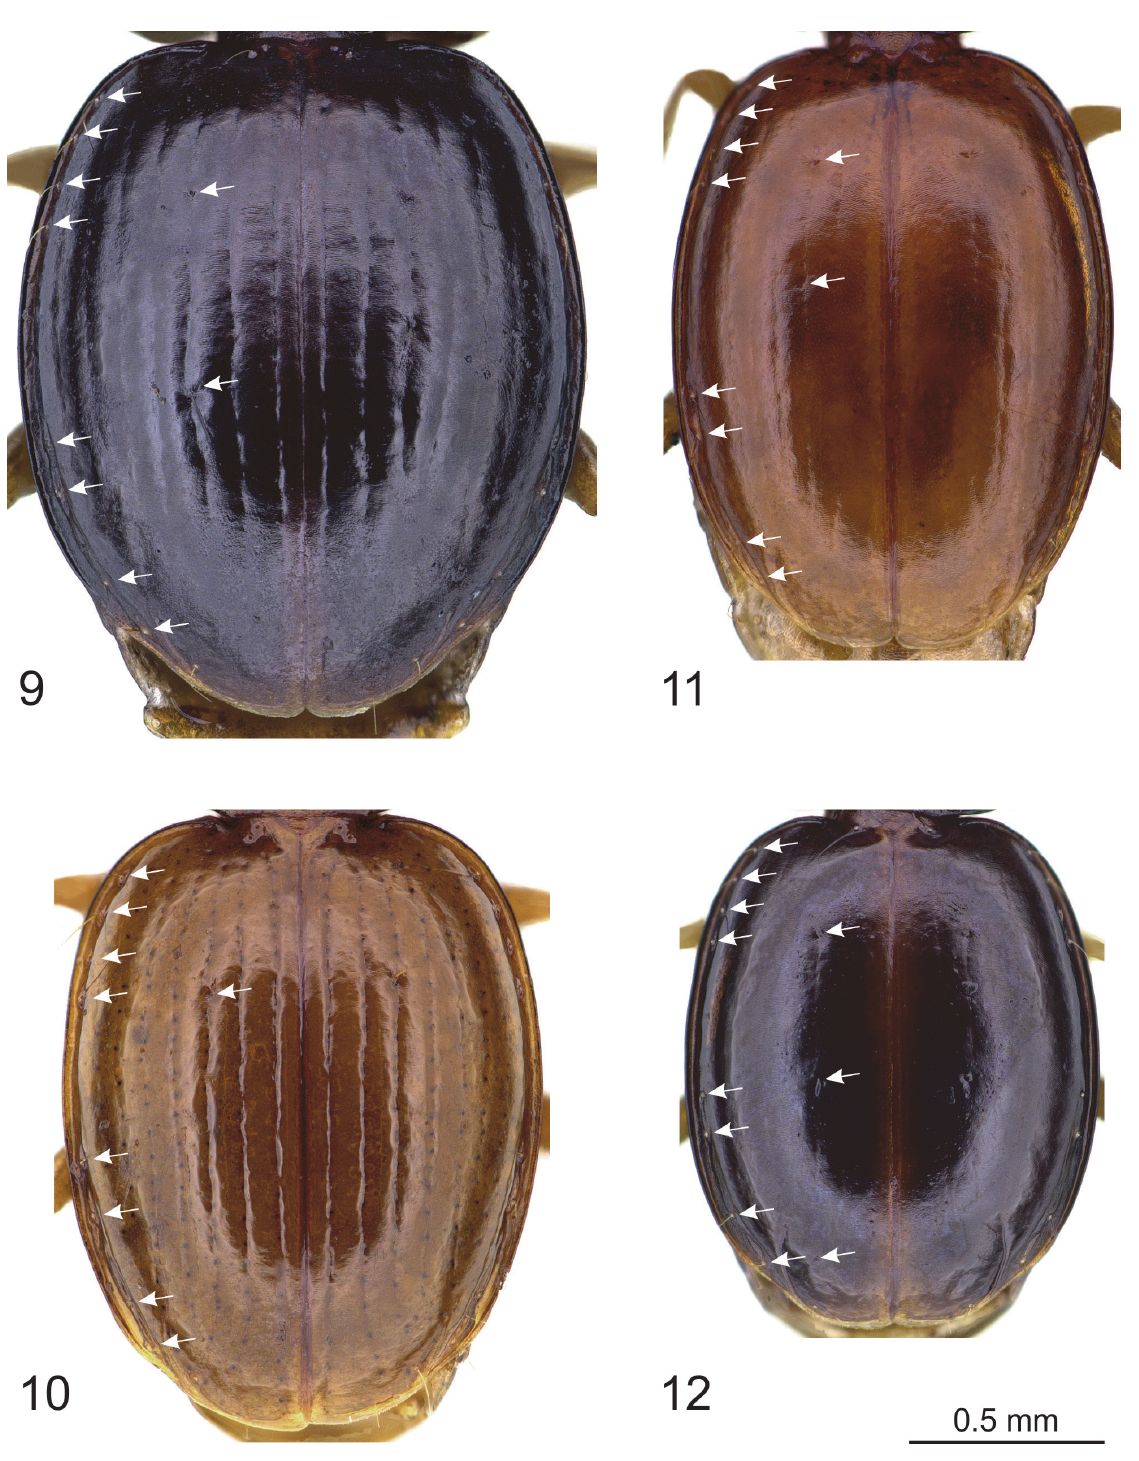
Figs 9–12. Trechus spp., elytra. 9 . T. mattisi sp. nov., paratype, ♂. 10 . T. transversicollis sp. nov., holotype. 11 . T. minitrechus sp. nov., paratype, ♂. 12 . T. nanulus sp. nov., paratype, ♂. The arrows point to the insertions of the discal setae, preapical seta (if present), and setae of the umbilical